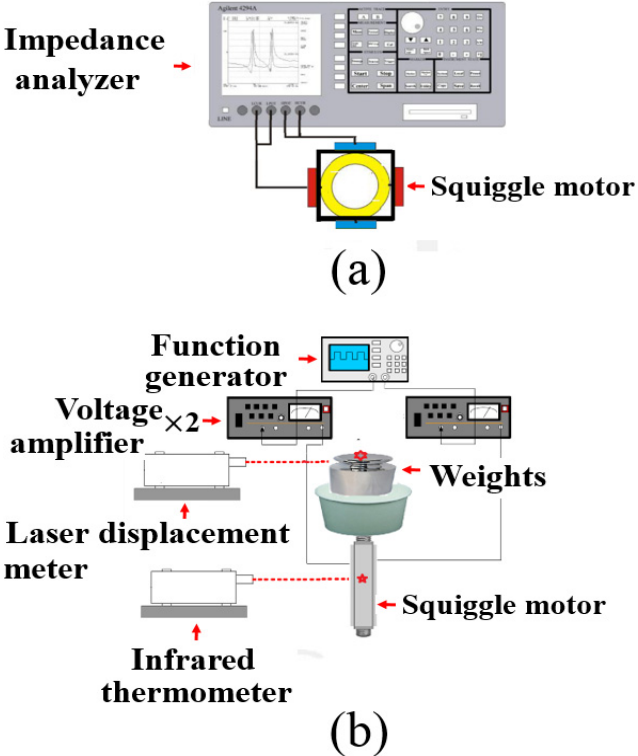
Figure 9. ( a ) The Agilent 4294A impedance analyzer measurement for the phases and resonant frequencies of A and B pairs of ceramics sheets for the rotary linear motor and ( b ) the whole measurement system of rotary linear motor.